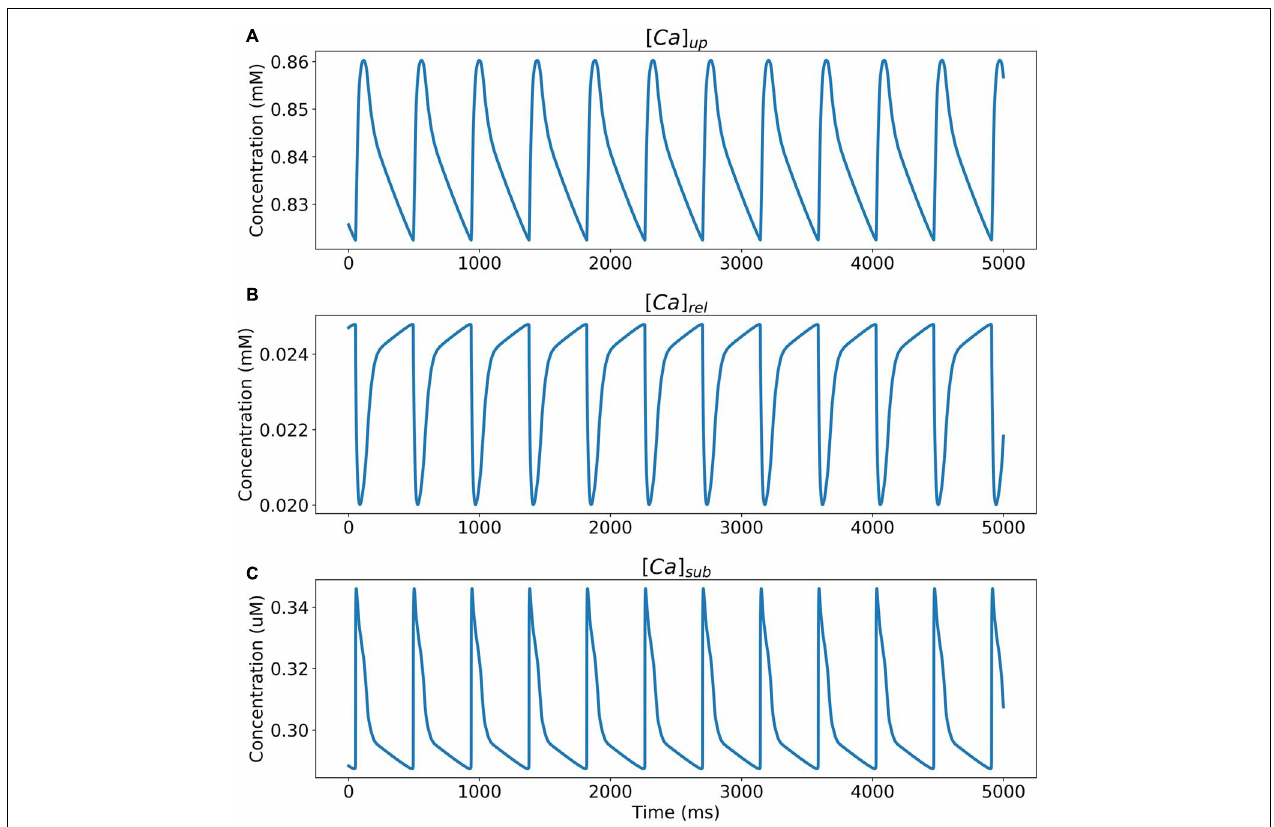
FIGURE 8 | Ca 2 + concentrations in (A) NSR ([Ca 2 + ] up ), (B) JSR ([Ca 2 + ] rel ), and (C) subspace ([Ca 2 + ] sub ) during spontaneous APs.